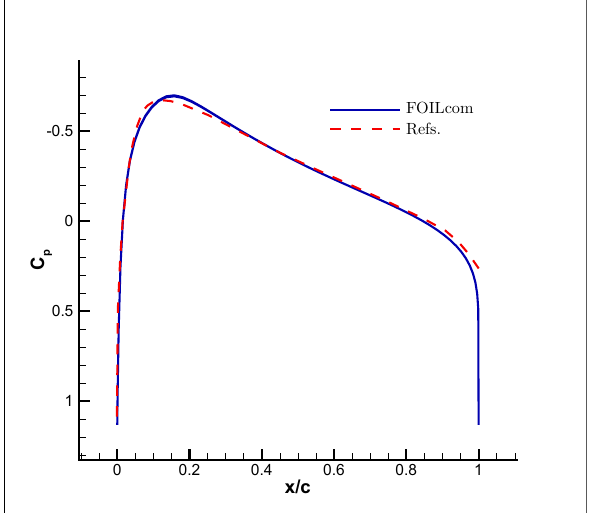
Figure 11. The pressure coefficient distribution. Comparison of FOILcom result and the one from References [4,22].